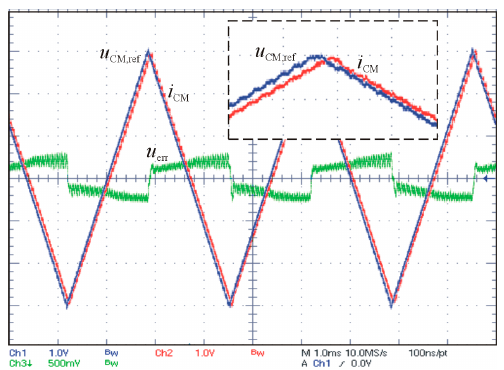
Figure 15. Selected waveforms in the laboratory prototype of the current modulator, with the CM operating in a single-channel configuration. The modulator’s output current magnitude is equal to the nominal one. Horizon scale = 1 ms/div, vertical scale = 4A (4V)/div (2 V/div for the error signal).